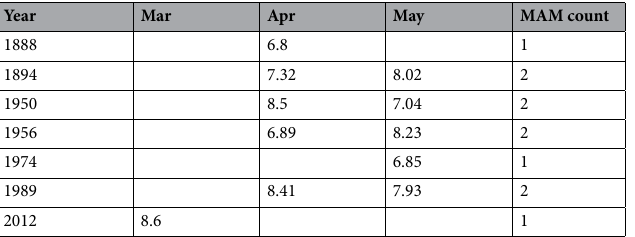
Table 3. Table showing autumn (MAM) monthly maximum weekly Murrumbidgee River heights at Hay (southern MDB) that exceed flood level (6.7 m), and seasonal count in the 126 years 1874–2019. Note the last April–May flood exceedance height in 1989 and one in March.